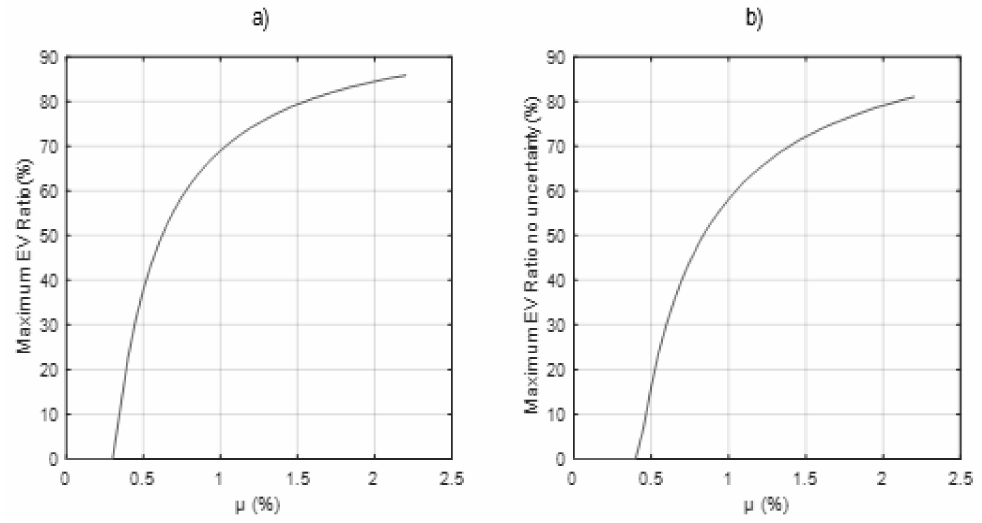
Figure 12. Maximum allowed EV integration ratio (%) that guarantees an economically viable project (( a ) with uncertainty, ( b ) without